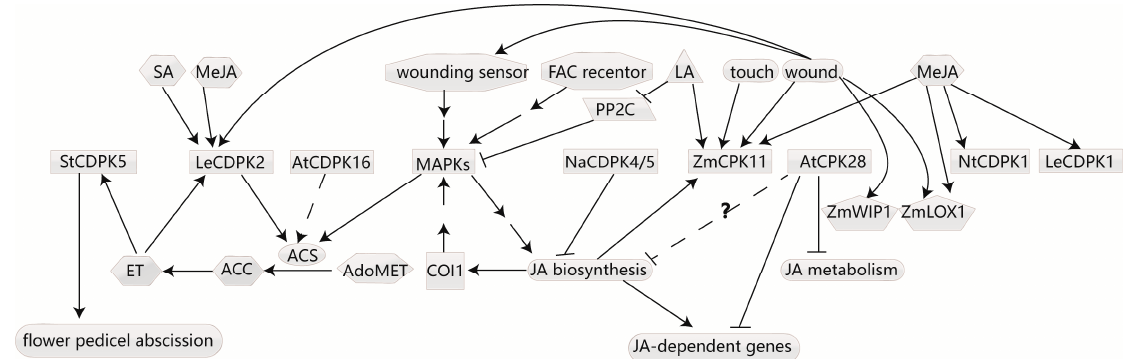
Figure 2. CDPKs affect ethylene and jasmonic acid biosynthesis and respond to several signals. The expression of LeCDPK2 can be aroused by ethylene (ET), methyl jasmonate (MeJA), salicylic acid (SA) and mechanical wounding. ACS, the key ethylene biosynthesis enzyme, can be phosphorylated and stabilized by LeCDPK2 and MAPKs to respond to wounding signaling. CDPKs in the wounding response show frequent crosstalk with MAPKs. Furthermore, MAPKs are required for JA biosynthesis, which is repressed by NACDPK4 and 5. AtCPK28 has been demonstrated to inhibit JA metabolism and the expression of some JA-dependent genes. It seems that AtCPK28 may also repress JA biosynthesis. JA, jasmonic acid; LA, linolenic acid. The dashed lines represent that there is only evidence in vitro. Question marks indicate that the relation is guessed. Arrows indicate promotion, and T bars indicate suppression.